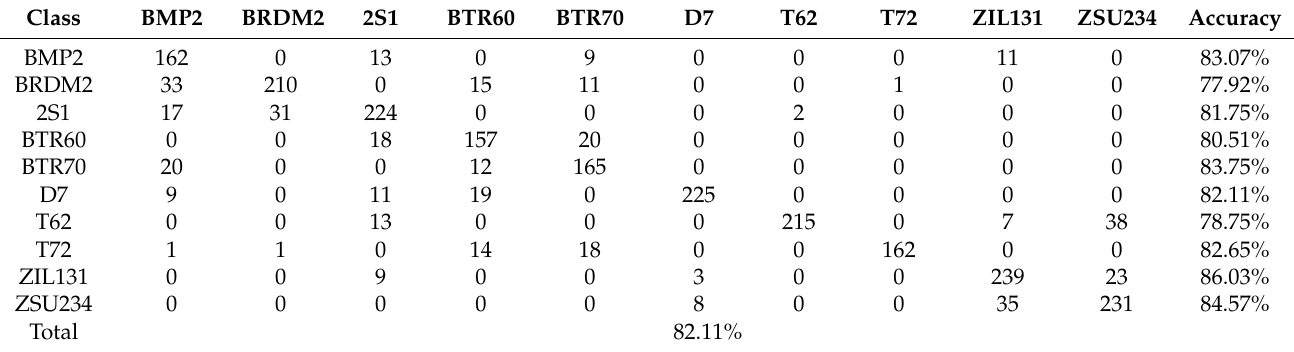
Table 5. Confusion matrix of testing results of the ADMF-CNN model trained on